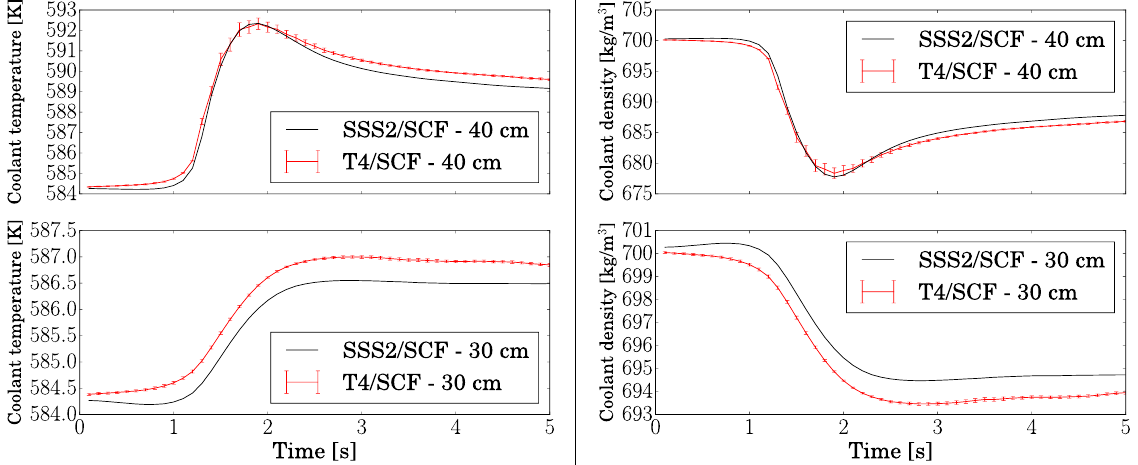
Figure 3: Average coolant temperature (in kelvins, left) and average coolant density (in kg / m 3 , right) for the same simulations as in Fig.